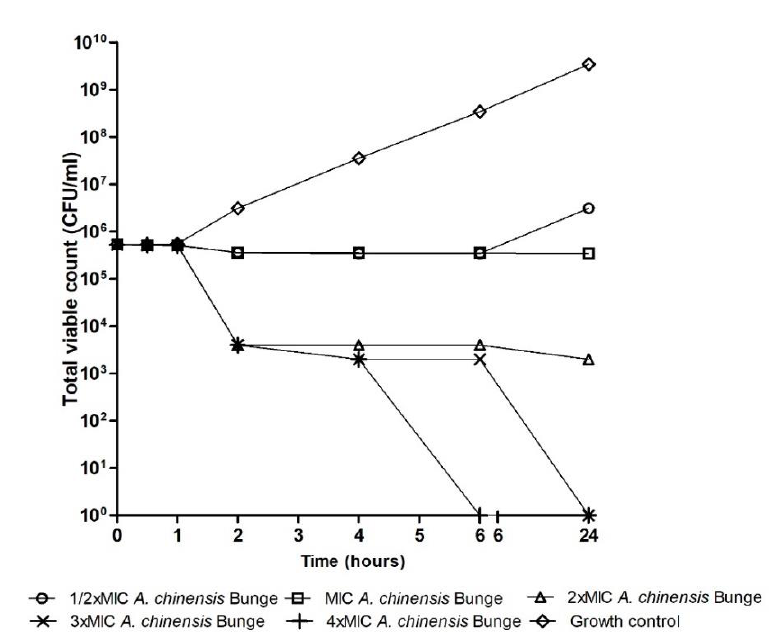
Figure 3. Total viable count of endogenous and inoculated Salmonella enteritidis QA0419, LE103, and 1F6144 mixture in the presence of Anemone chinensis Bunge. 216